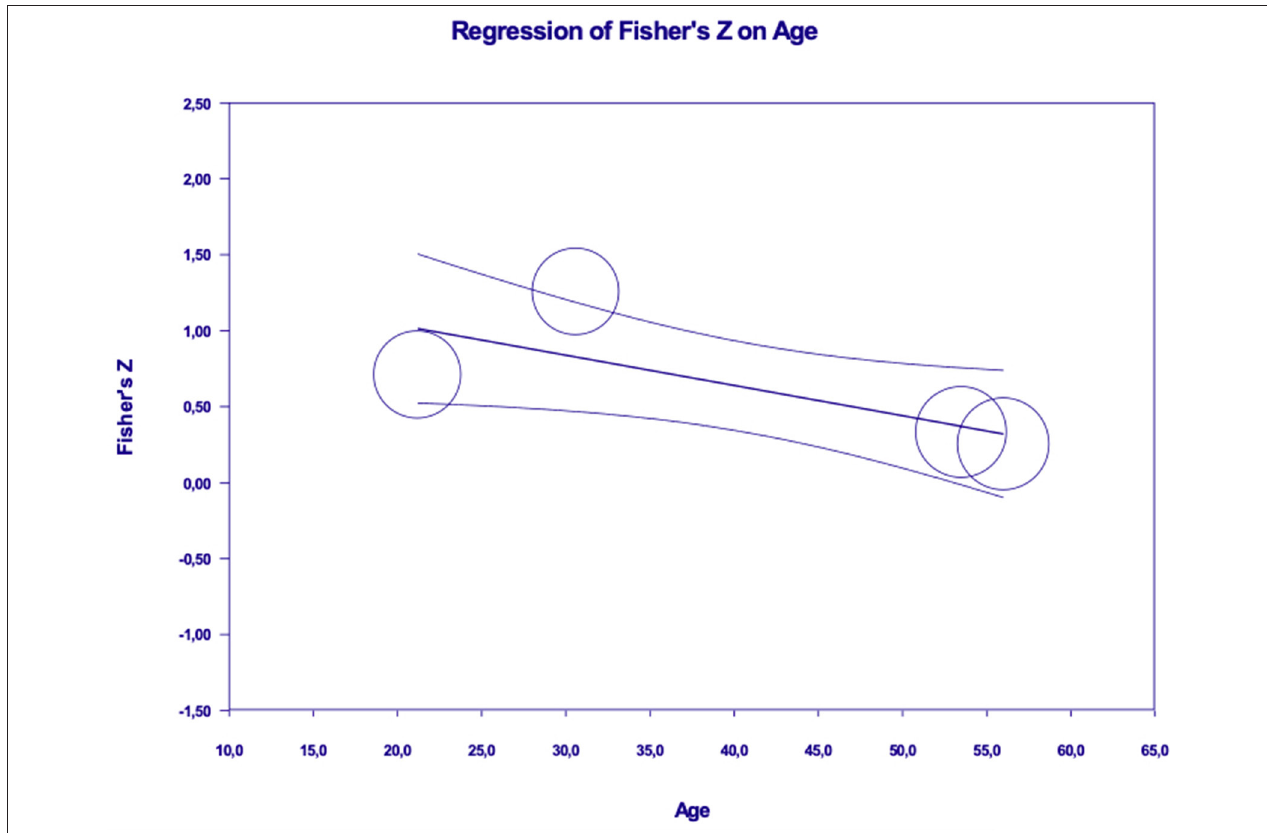
FIGURE 9 | Moderation effect of age in the relation between emotions and energy saving behaviors (or